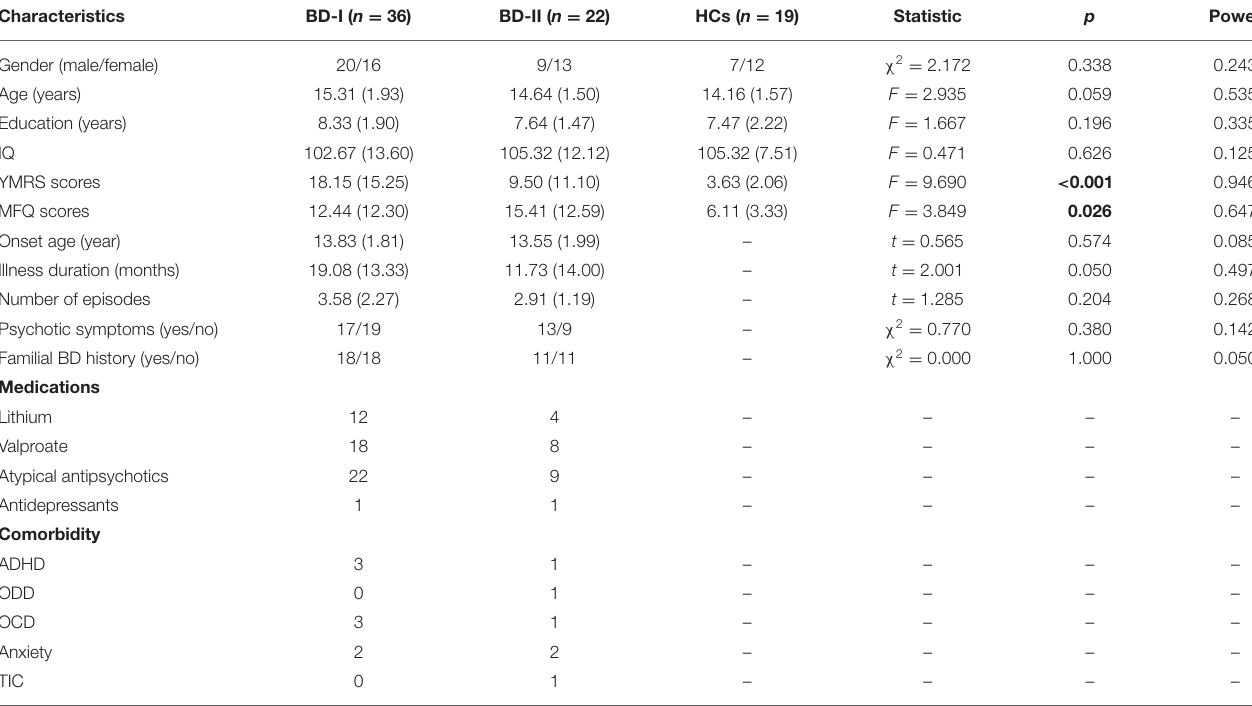
TABLE 1 | Demographic and clinical data of all participants.